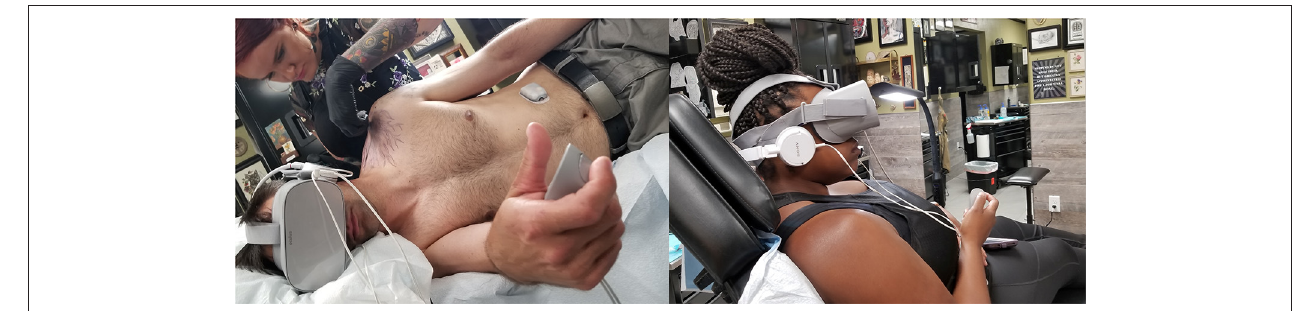
FIGURE 2 | Graphic representation of the experimental